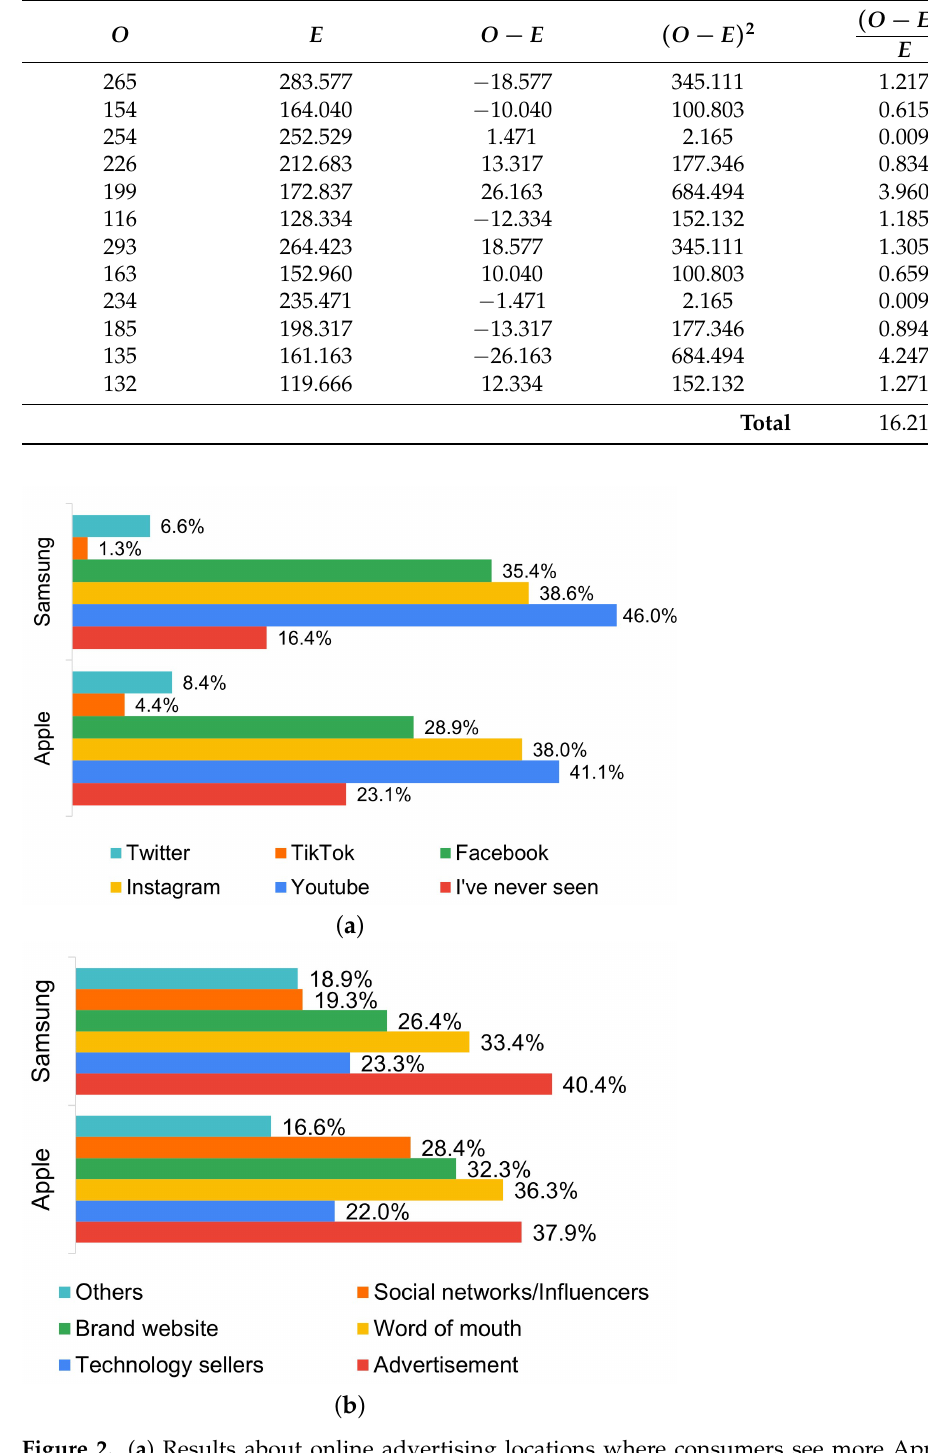
Table 5. Chi-square calculus for the question “For you, what is the source of information of the products from Apple and Samsung?”. O: Observed. E: Expected.